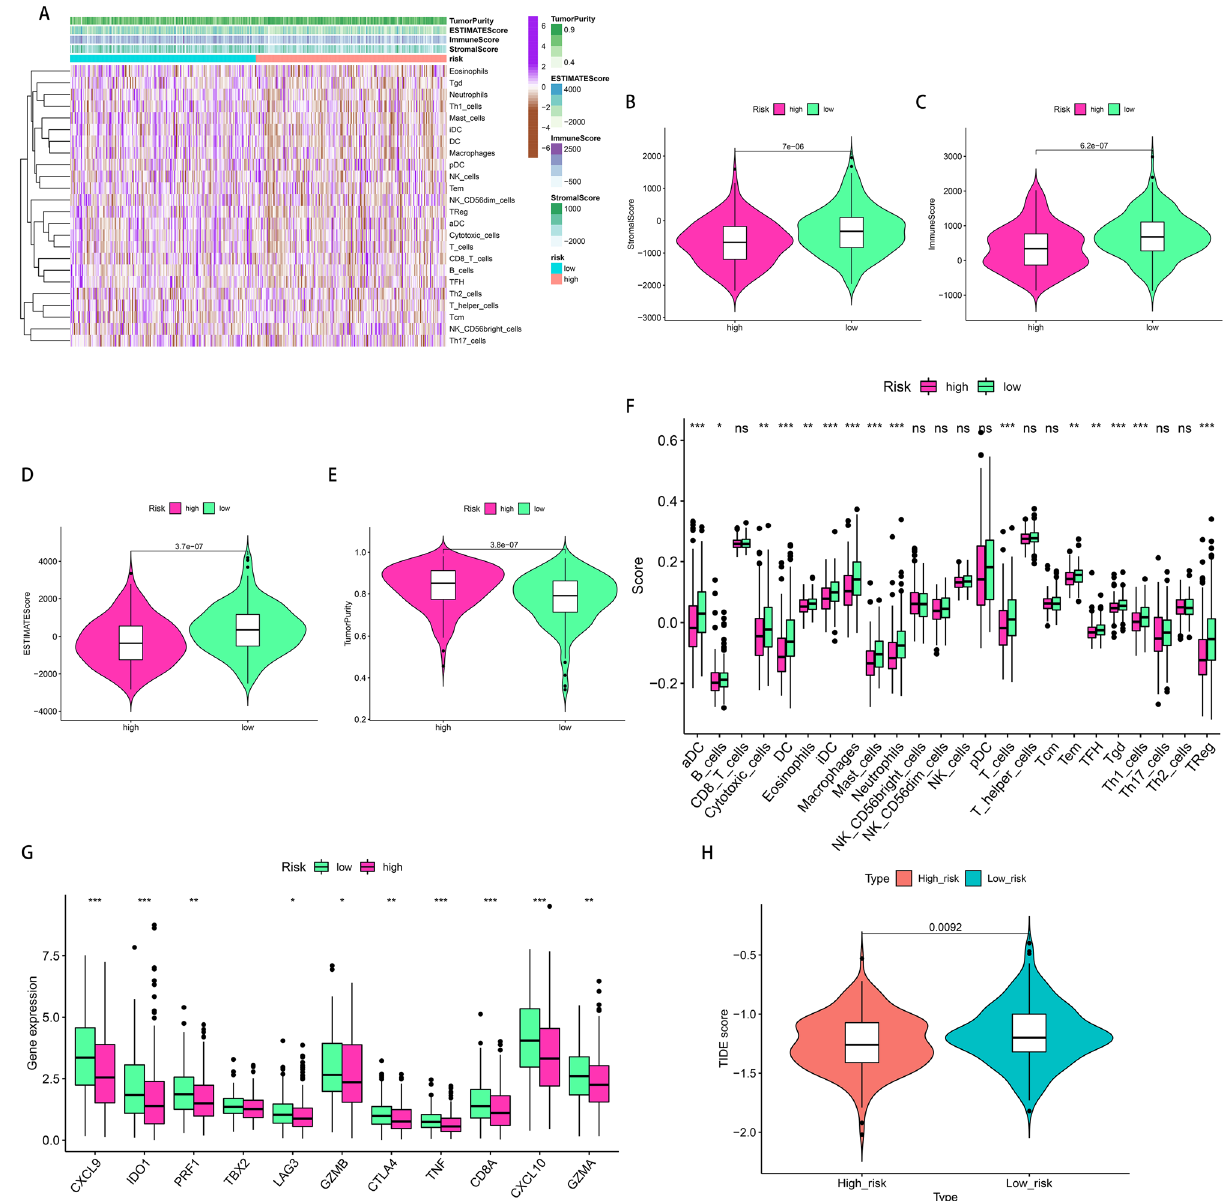
Figure 6. Estimation of the immune status and response to immunotherapy based on the signature in the high-risk and low-risk groups for the whole set. ( A ) Heatmap of the immune scores, stromal scores, tumor purity, ESTIMATE scores and immune-infiltrating cells in the two groups. ( B – E ) Violin plots for the immune scores, stromal scores, ESTIMATE scores, and tumor purity. ( F , G ) Boxplots of immune cells and immune checkpoints expression. ( H ) TIDE prediction difference in the two groups. *P < 0.05; **P < 0.01; ***P < 0.001; ns: no